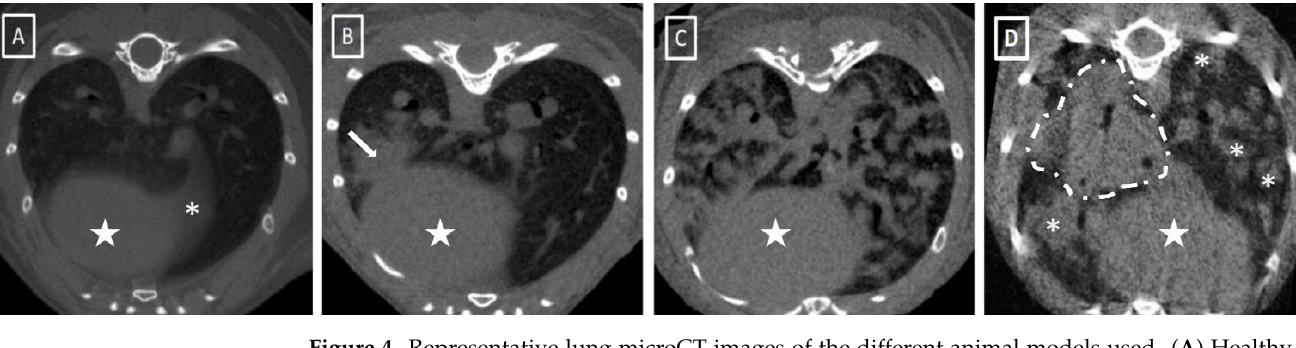
Figure 4. Representative lung microCT images of the different animal models used. ( A ) Healthy animal. Note the absence of intrapulmonary soft tissue structures except vessels, heart (white star) and the first part of the diaphragm (white asterisk). ( B ) Transgenic lung tumor model with a solitary lung tumor (white arrow) in contact with heart burden (white star). ( C ) Metastatic lung cancer model. Presence of multiple soft tissue structures compatible with lung tumors. ( D ) Fungal infection model. Presence of multiple hyperdense structures (fungal abscesses, asterisks) and a consolidated lung tissue dorsal to the heart (area delimited by a white dashed line).